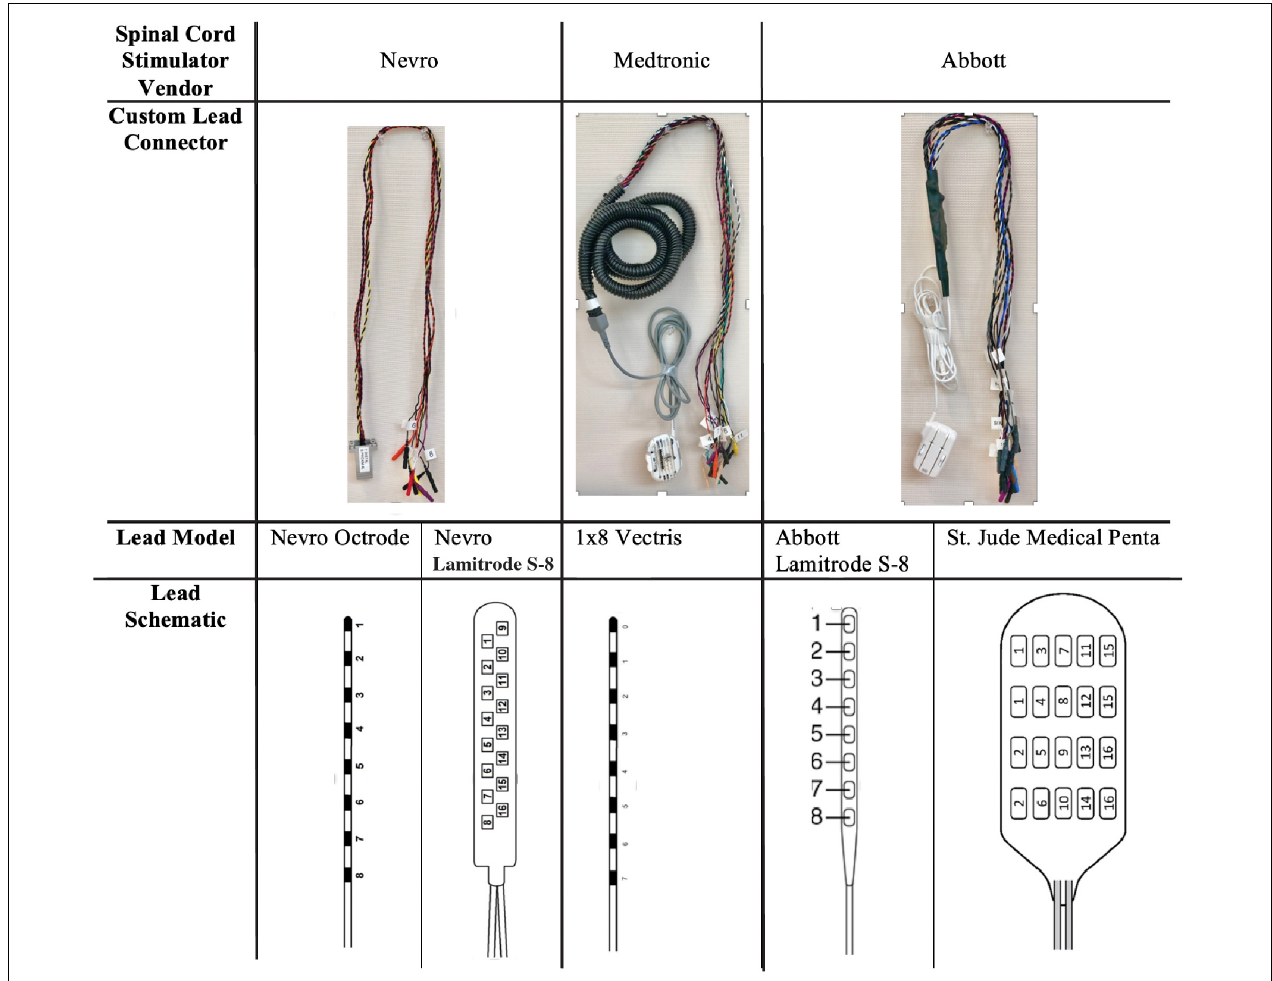
FIGURE 2 | Lead types used in this study and customize connectors. The difference types of leads (based on medical device company) are shown. The top row demonstrates the customized connectors that were used to couple the leads to the external recording system. The bottom row demonstrates the schematics of the leads used in the